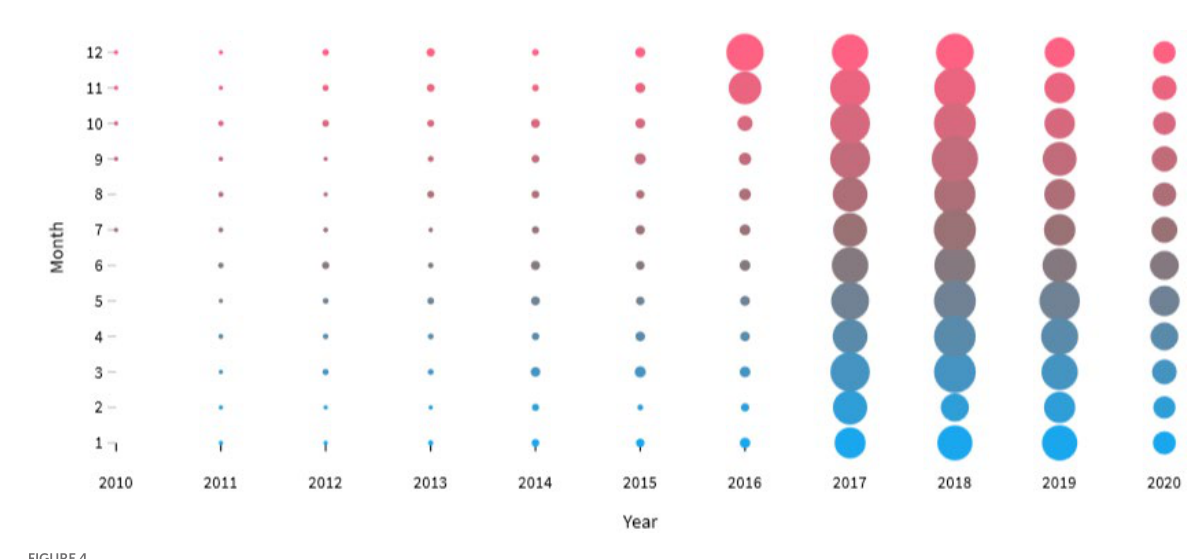
FIGURE 4 The year and month distribution of the topics.